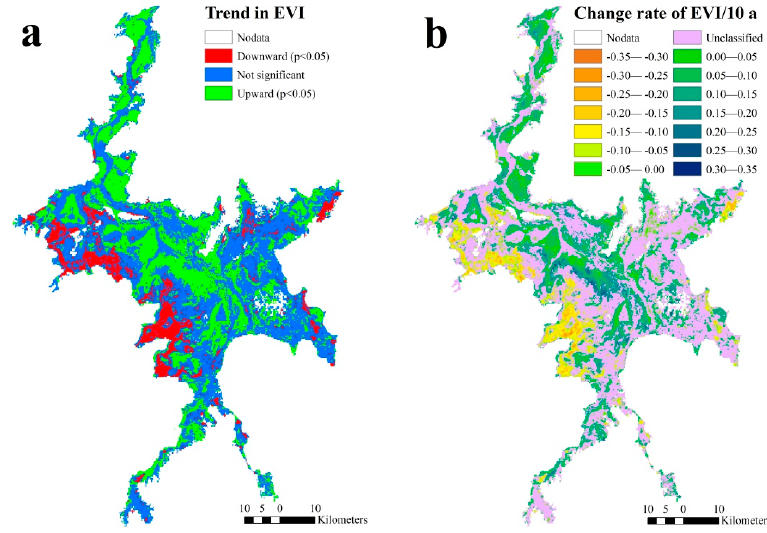
Figure 2. Spatial distribution of variation trend ( a ) in EVI and the change rate; ( b ) of EVI with statistically significant trends during 2000–2012. Table 1. Distribution of elevation of regions that experienced significant enhanced vegetation index (EVI) changes. Var: Variance; Std: Standard